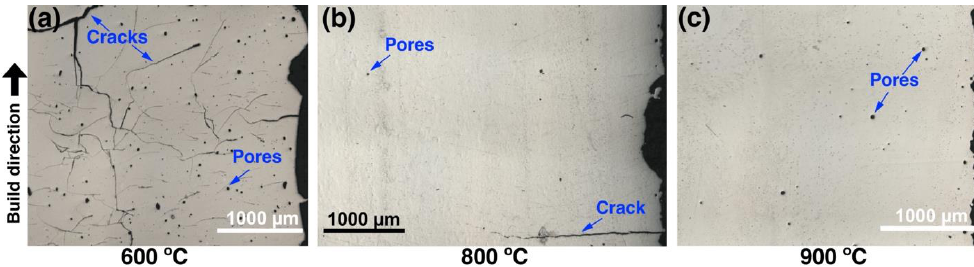
Figure 4. Optical images of the cross-sections of the samples fabricated from MAPS powder. The images show representative cross-sections of the samples obtained using different preheating temperatures: ( a ) 600 ◦ C (sample 1_600), ( b ) 800 ◦ C (sample 1–800), ( c ) 900 ◦ C (sample